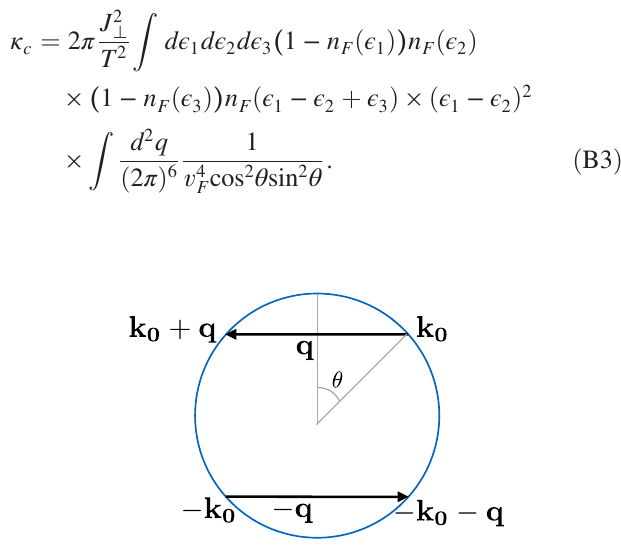
FIG. 4. Choice of k 0 for a given q when integrating over k , k 0 in Eq. (4). The blue circle is the Fermi